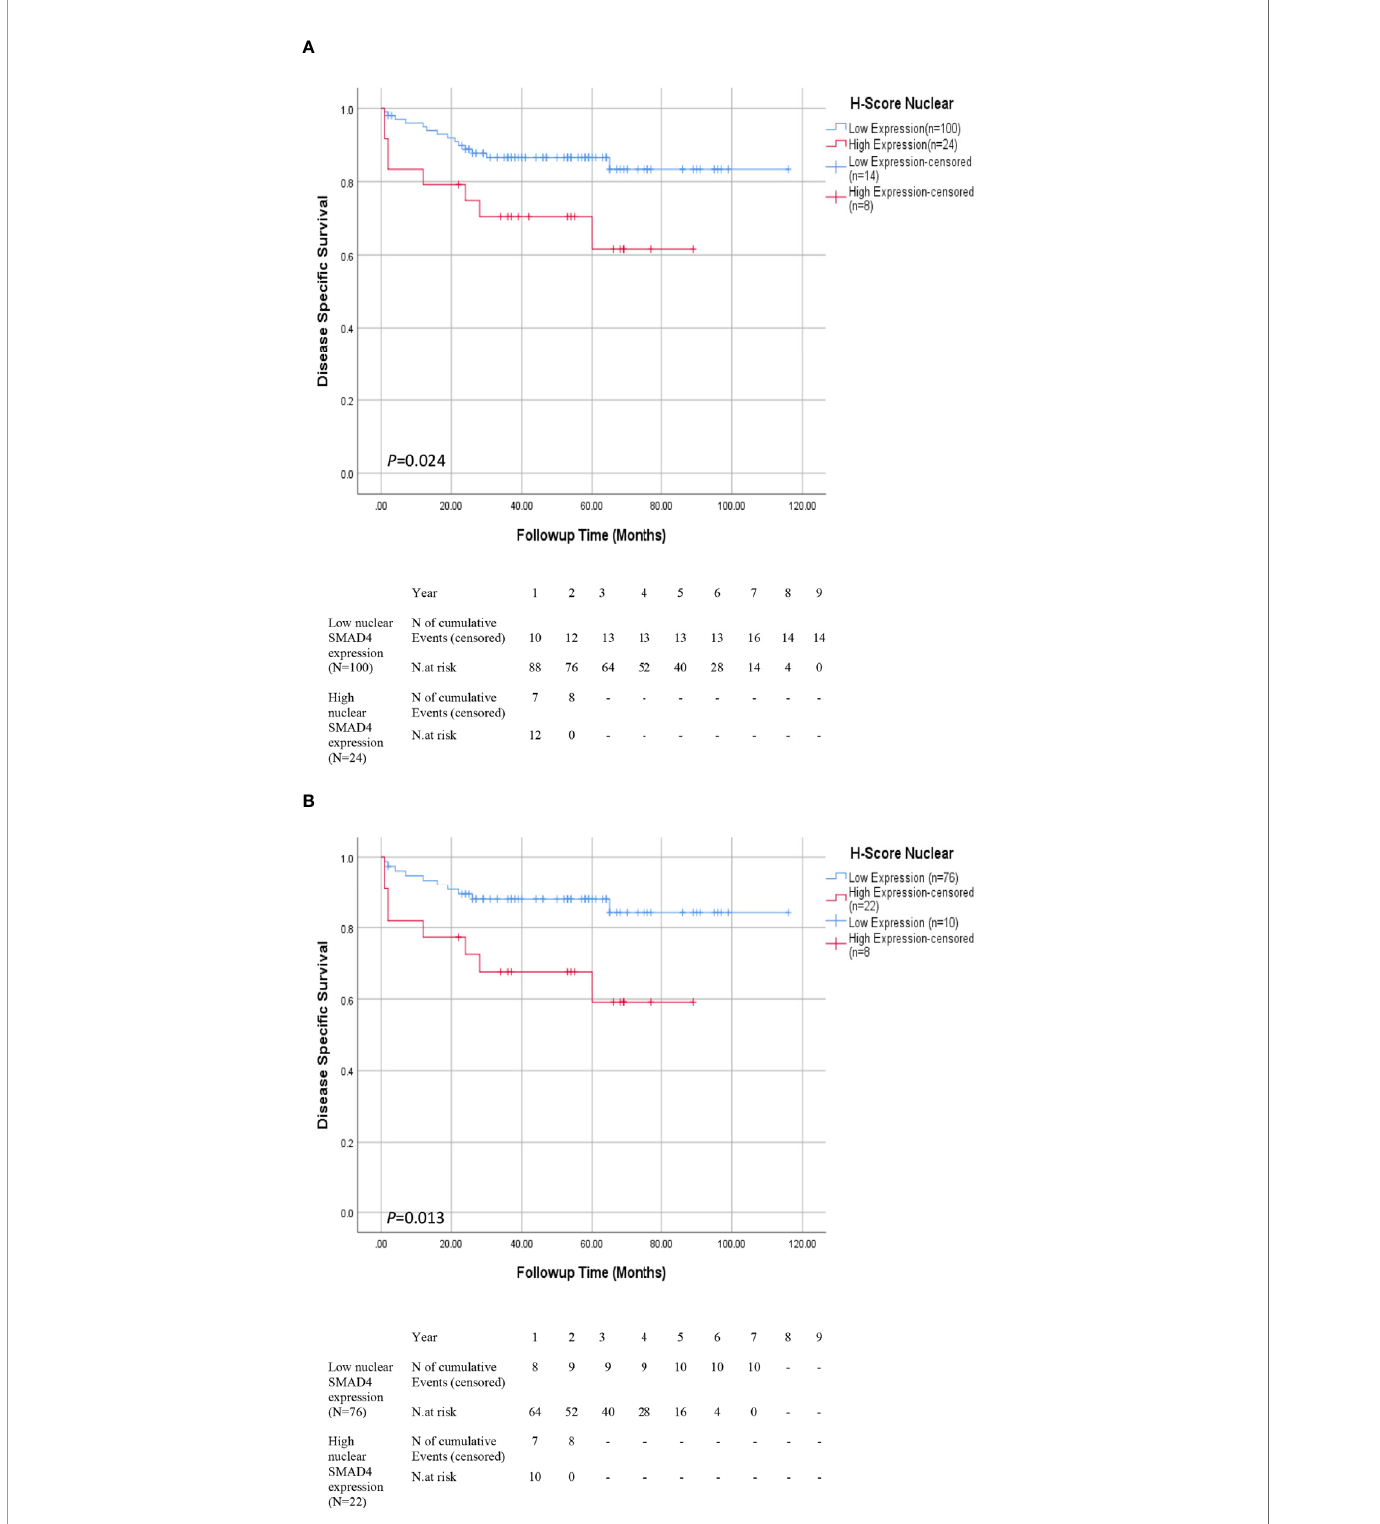
FIGURE 2 | Association Between Expression of SMAD4 and Survival Rates in Patients With Renal Cell Carcinoma (RCC). Disease-speci fi c survival (DSS) with nuclear SMAD4 expression grouped into high versus low expression levels in (A) RCC and (B) ccRCC patients. Number of events and at risk patients on the Kaplan Meier estimates are presented underneath the graphs (A, B)